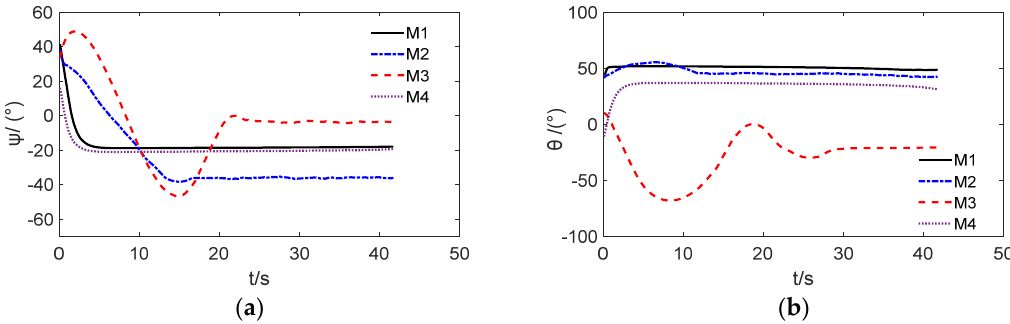
Figure 14. Velocity-inclination change curve of each follower missiles during the cooperative attack on target 3 based on the MPC method: ( a ) Trajectory deflection curve; ( b ) Trajectory inclination curve.